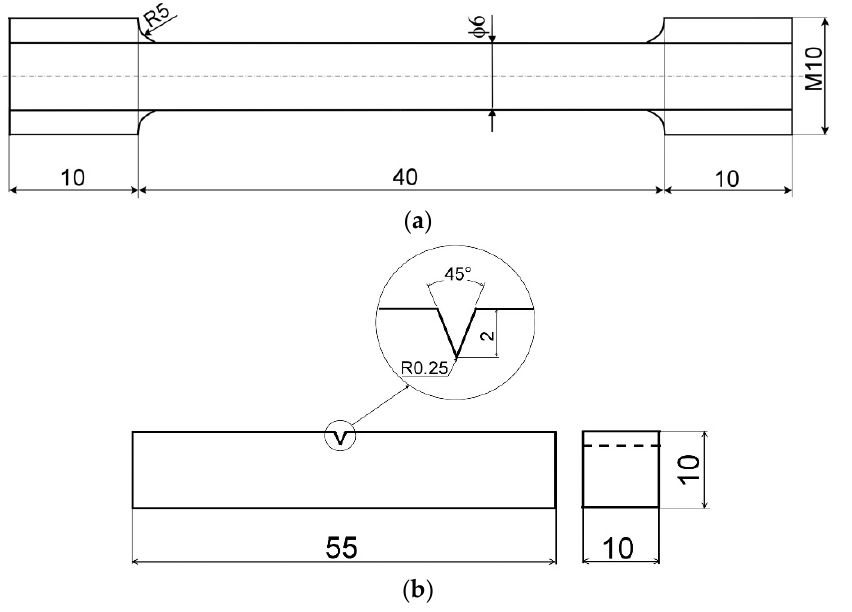
Figure 1. Schemes of test specimens used for individual mechanical tests: ( a ) uniaxial tensile test specimen and ( b ) Charpy V-notch impact bending test specimen. All dimensions are in mm.